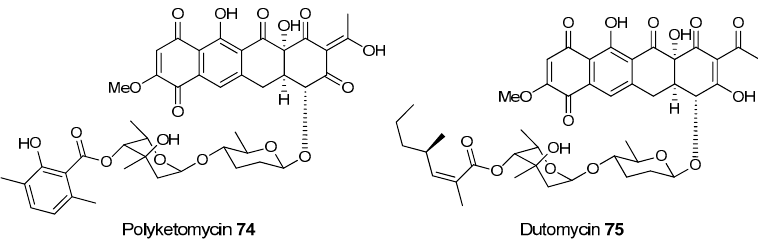
Figure 18. Cervimycins, isolated from cave derived Actinomycetes, are related to known tetracycline antibiotics 74 and 75 .